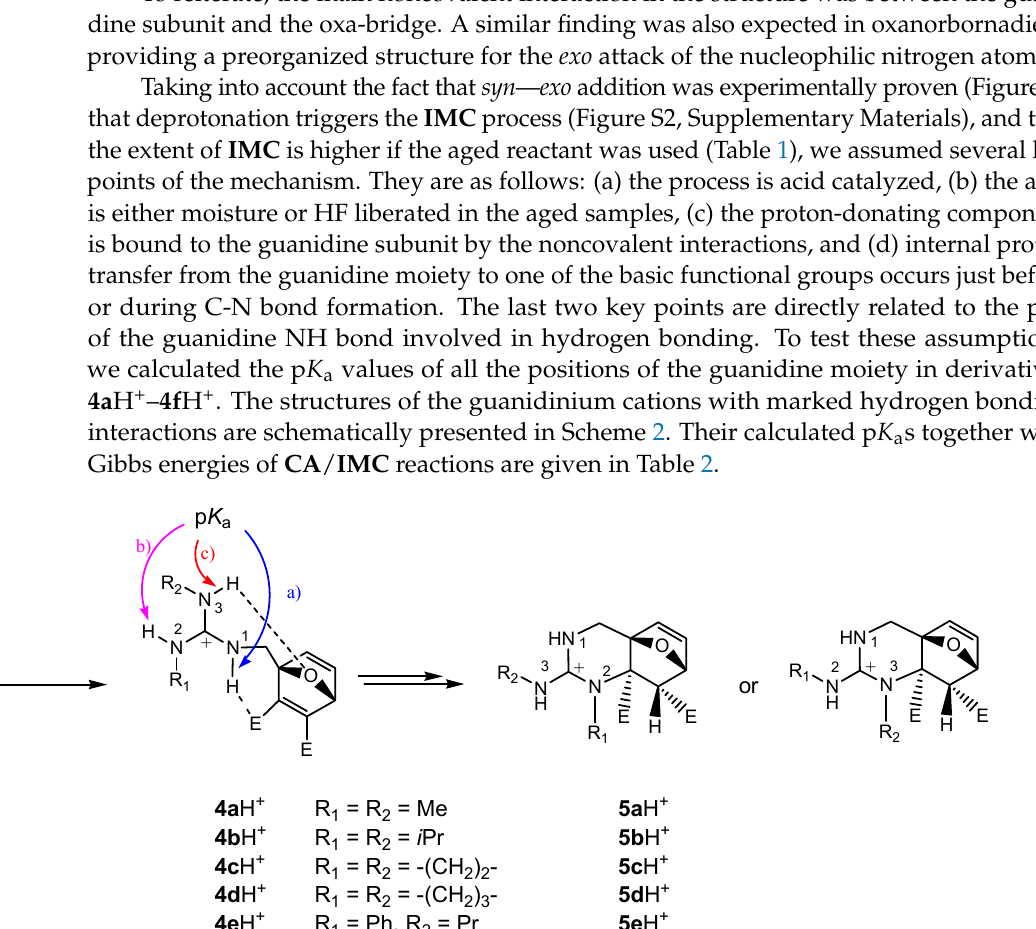
Figure 2. X-ray structure of the derivative 7d· HPF 6 .